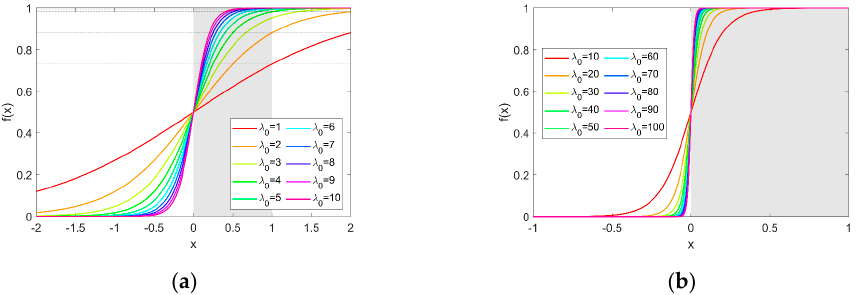
λ ; ( a ) λ = 1, 2, 3, 4, 5, 6, 8, 10, ( b ) 0 0